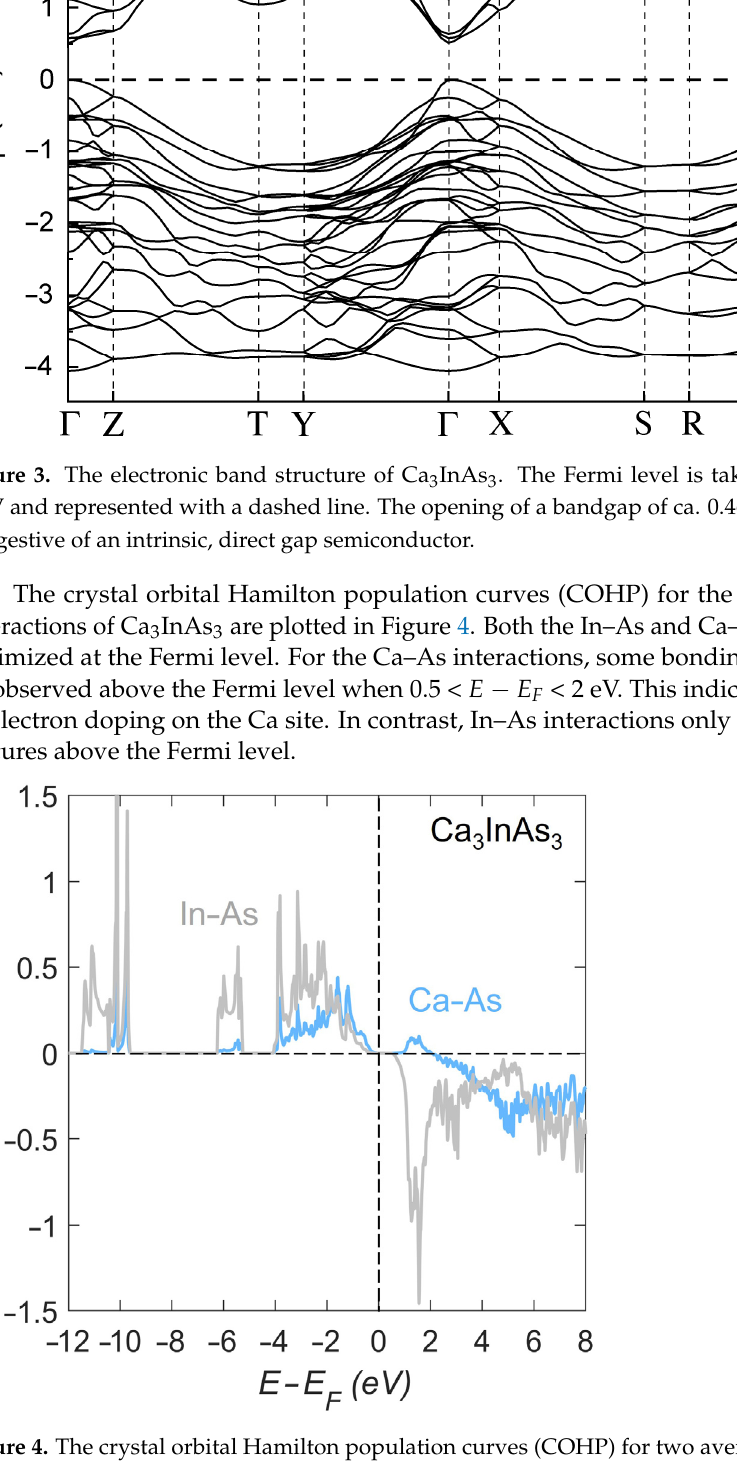
Figure 4. The crystal orbital Hamilton population curves (COHP) for two averaged interactions in Ca 3 InAs 3 . The In–As interactions are optimized at the Fermi level. Ca–As interactions are almost Ca 3 InAs 3 . The In – As interactions are optimized at the Fermi level. Ca – As interactions are almost fully optimized at the Fermi level. fully optimized at the Fermi